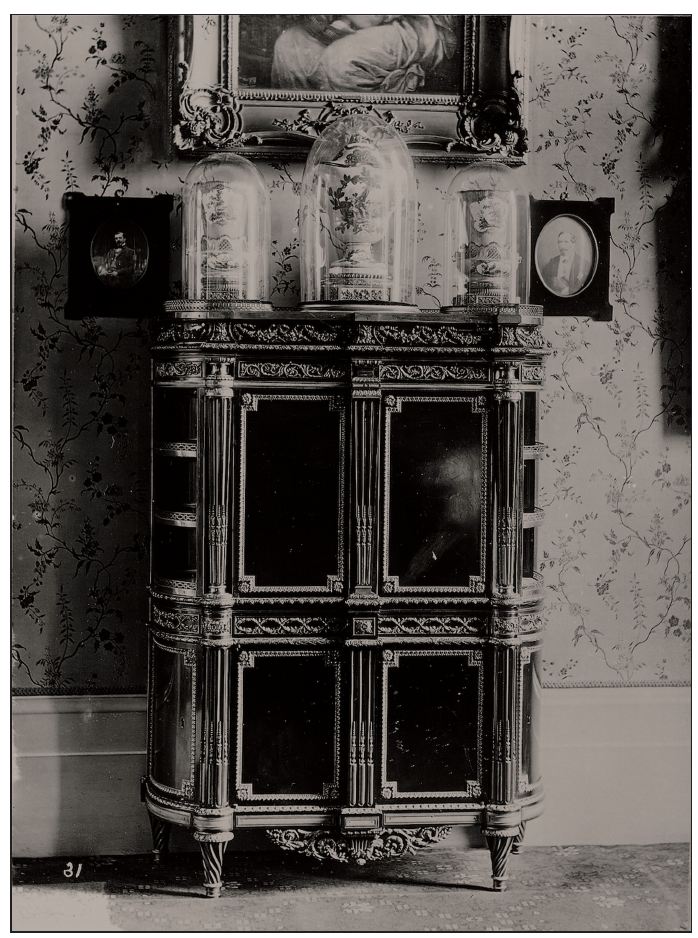
Fig. 6 : A detail of the boudoir at Hertford House showing photographs of Richard Wallace taken in 1857 (left) and the 4th Marquess of Hertford by Carjat, taken c. 1860 (right), Wallace Collection Picture Library. © The Trustees of the Wallace Collection,